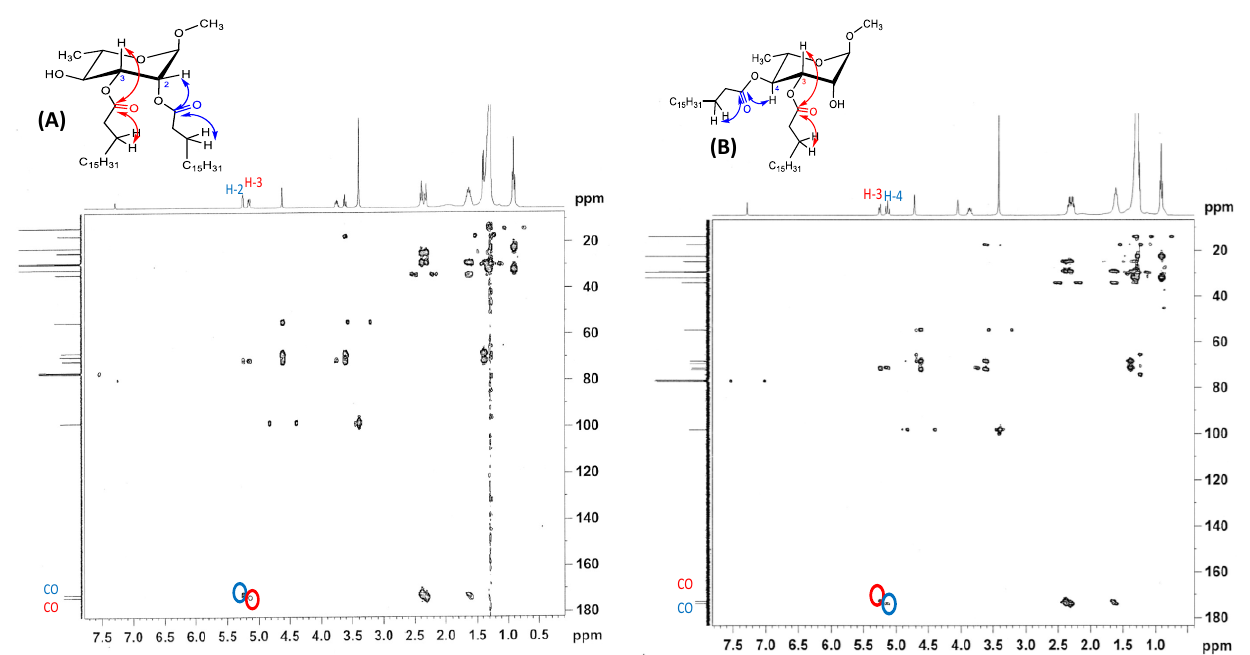
Figure 2. Confirmation of CO group positions: ( A ) HMBC spectrum of 4 , and ( B ) HMBC spectrum of 5 . The red color in structure and spectrum (A and B) indicated the CO interactions at the C-3 position for compounds 4 and 5 . The blue color in structure and spectra indicated the C-2 CO (Figure A, 4 ) and C-4 CO (Figure B, 5 ) interactions and positions, respectively.